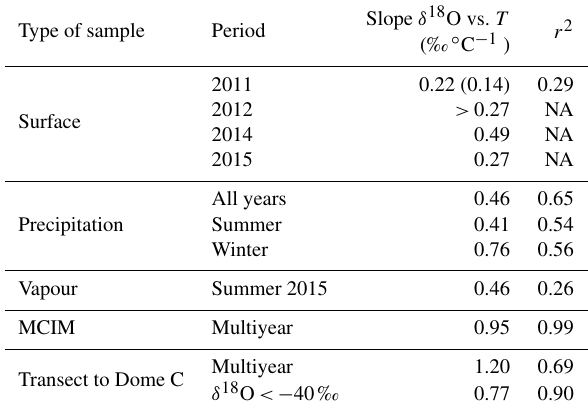
Table 5. Summary of the different isotope temperature relationships observed for different datasets. Because of the 2-month shift, sur- face snow slopes are calculated using the difference between the extremes of isotopic composition and temperature as detailed in Sect. 3.1.2. Isotopic composition data were not sampled in sum- mer 2012, which probably causes an underestimation of the slope. In 2011, the dephasing was sufficiently small to perform a linear re- gression, the result of which is shown in parentheses. The slopes for precipitation, vapour and MCIM outputs were obtained by linear re- gression. All correlations are significant ( p values < 0.05). Summer corresponds to the months from December through March, while winter from April through